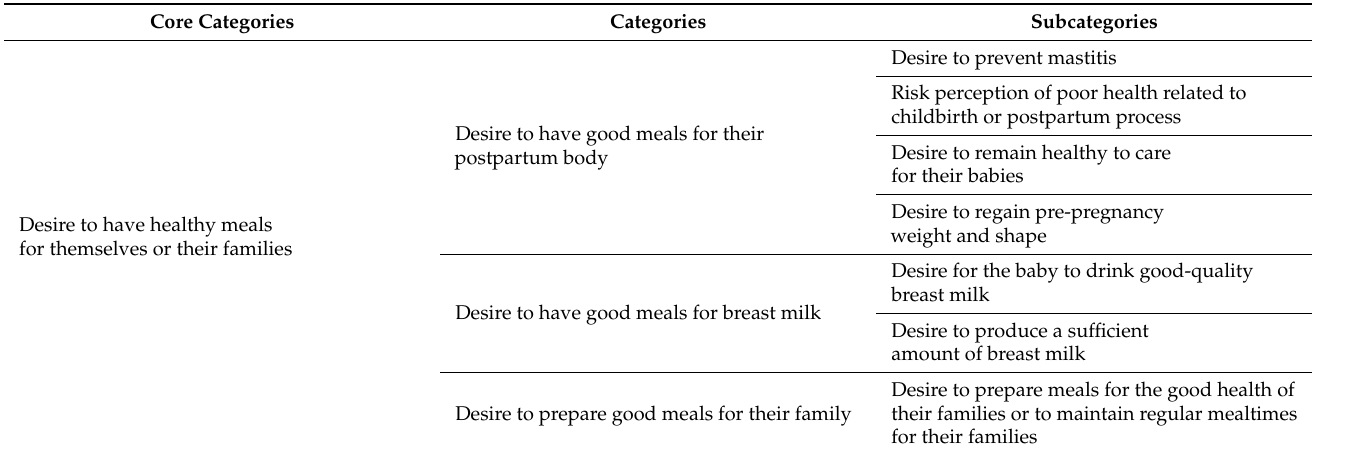
Table 2. Psychosocial experiences related to dietary behavior of lactating